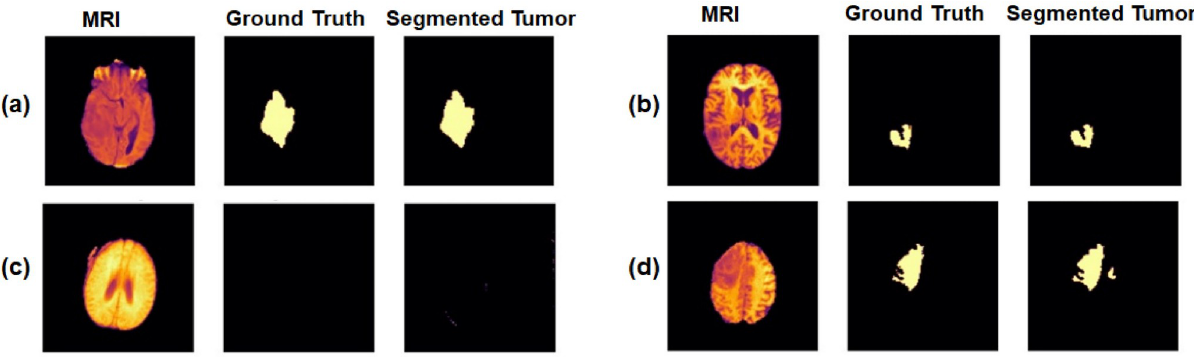
Fig 28. Sample segmentation outputs for 3D U-Net